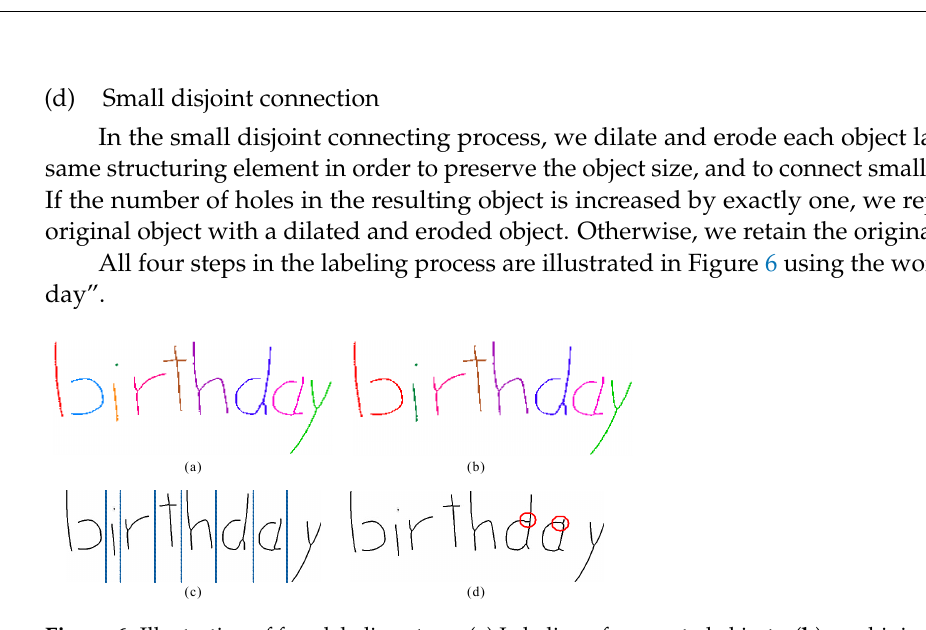
Figure 6. Illustration of four labeling steps: ( a ) Labeling of connected objects, ( b ) combining labels for characters b and i using left open and uncovered label combination categories, ( c ) label separation, and ( d ) small disjoint connection of characters d and a.